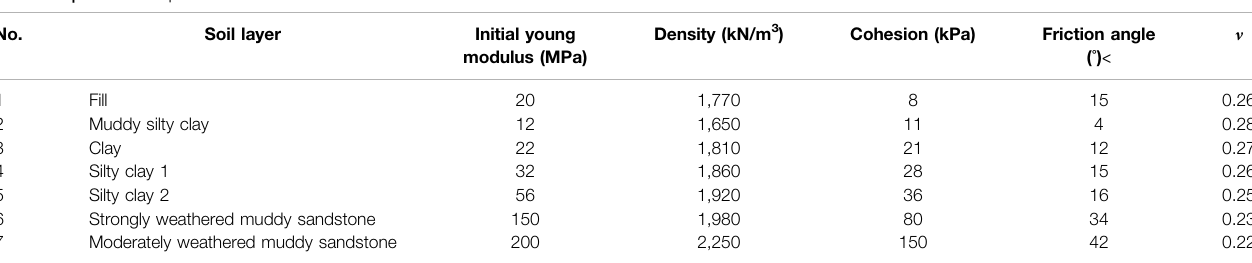
TABLE 3 | Calculation